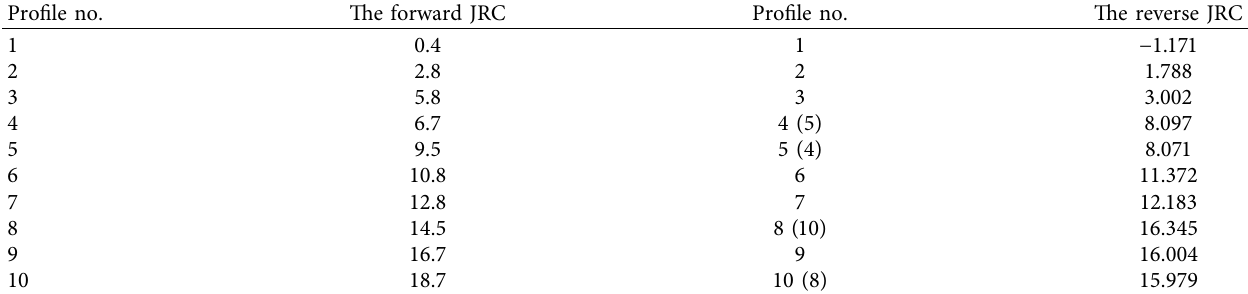
Table 4: Reordering of standard roughness profiles according to the reverse JRC. Profile no.